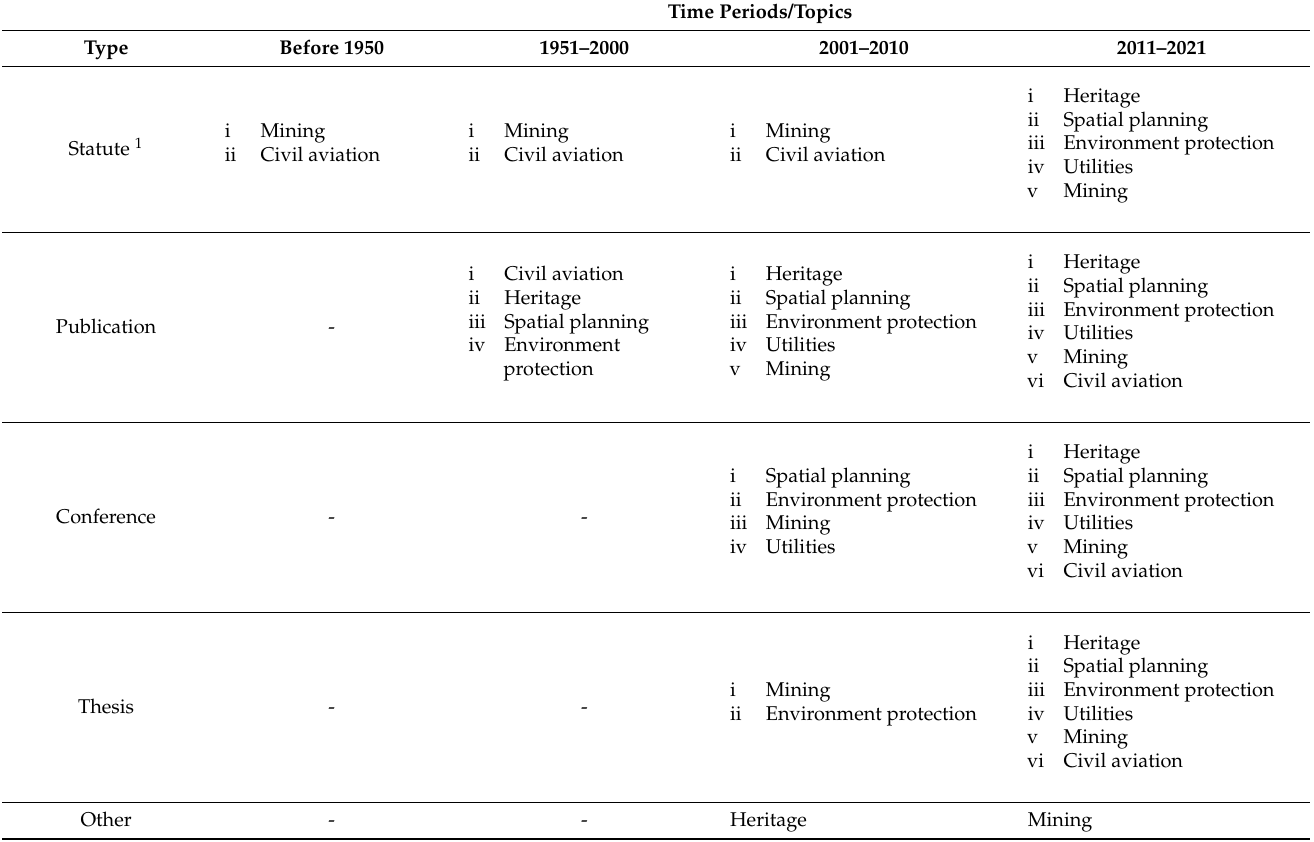
Table 3. PLR topics referenced per time period and data